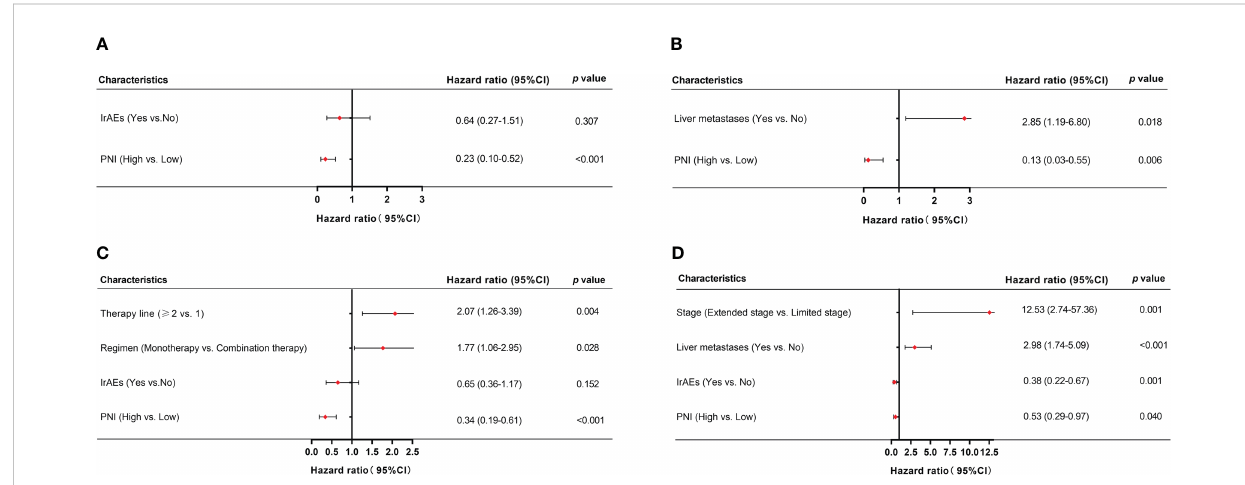
FIGURE 5 Multivariate analysis of factors associated with PFS and OS in SCLC patients. (A, B) PFS and OS in SCLC patients treated with PD-L1/PD-1 inhibitors monotherapy. (C, D) PFS and OS in SCLC patients treated with PD-L1/PD-1 inhibitors combined with